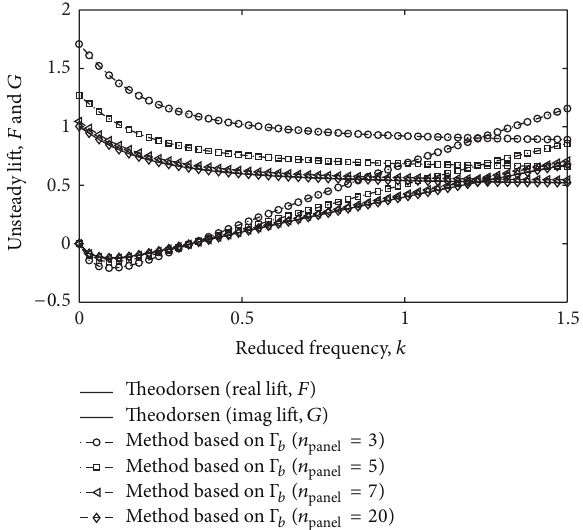
Figure 7: Lift acting on the airfoil due to step change in airfoil downwash predicted using ROM based on Γ 𝑏